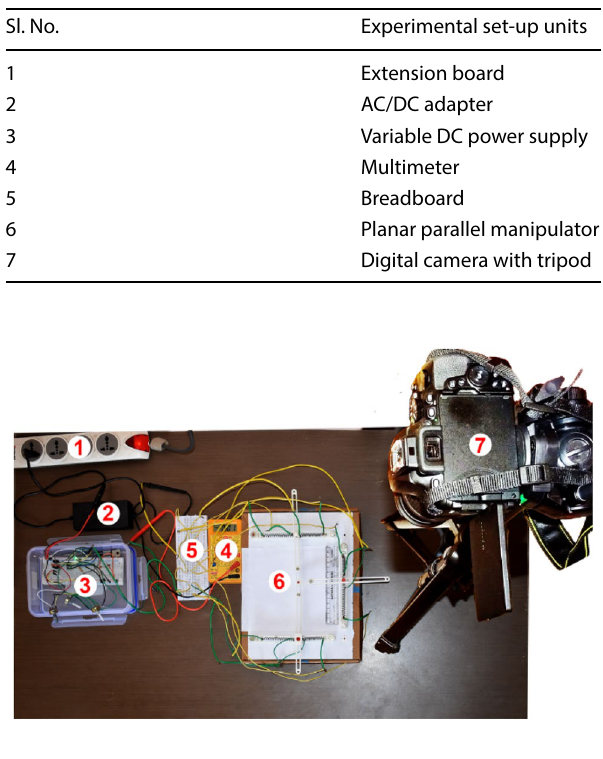
Fig. 9 Experimental